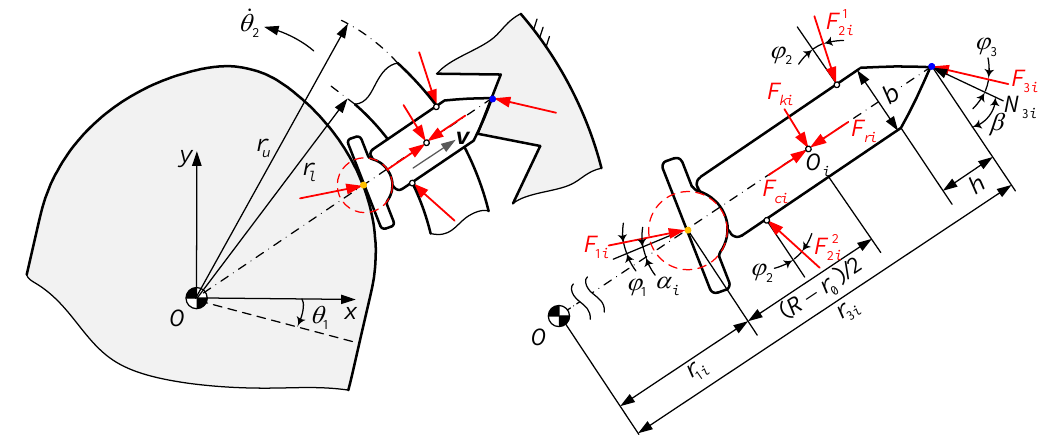
Figure 10. Force state of the i -th tooth during the rise